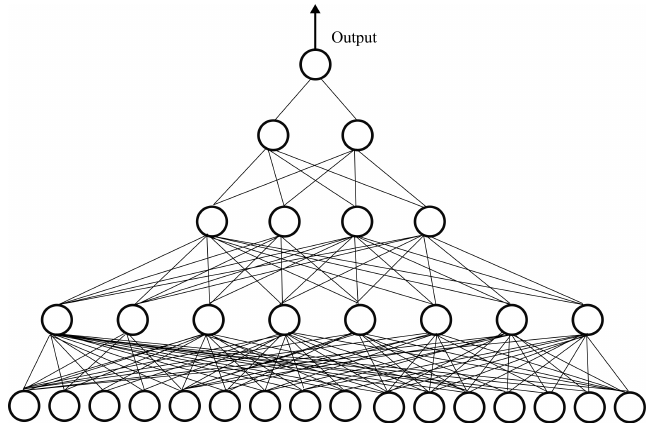
Figure 7. Details of the MLP with five